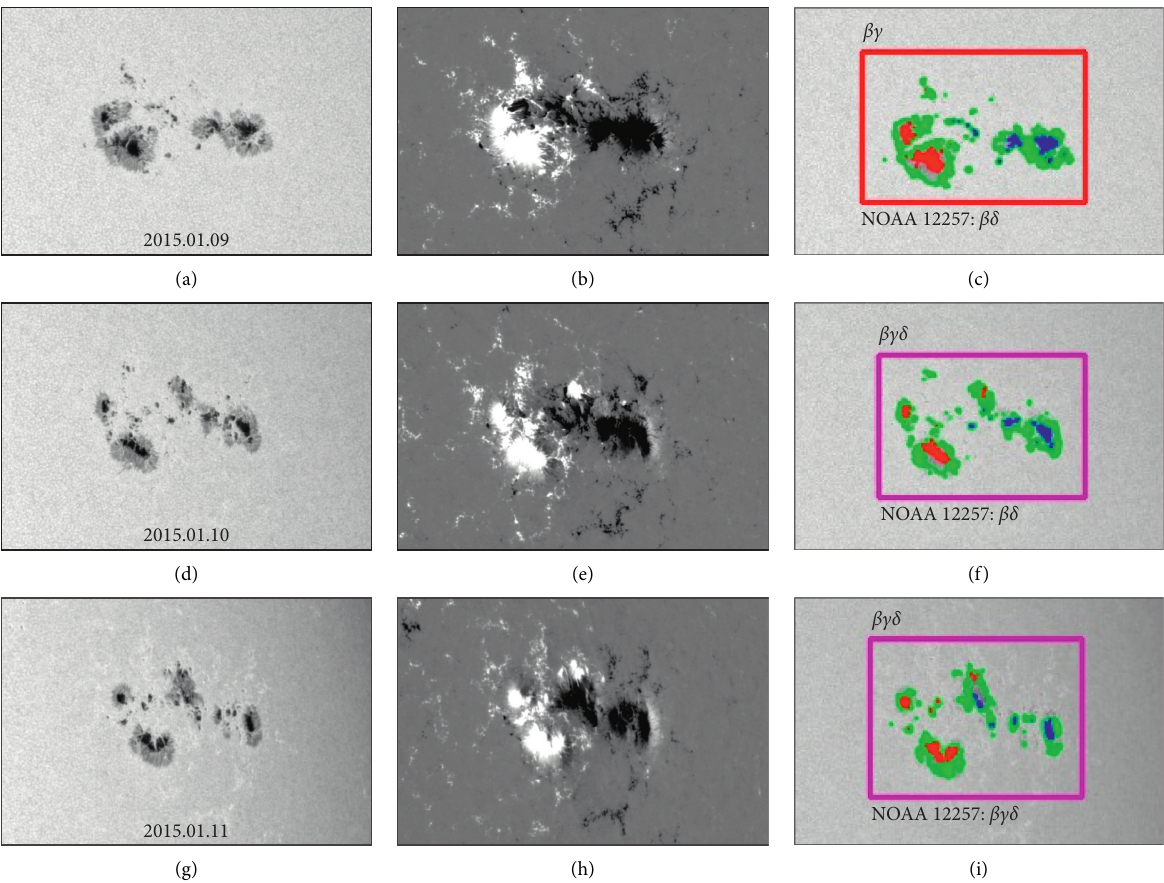
Figure 13: The classifications of NOAA 12257 given by our method and NOAA. The columns from left to right are the continuum image, magnetogram, and the detection result, respectively. The rows show the evolving procedure, which is on the 9th, 10th, and 11th of January 2015, respectively. All the times are 20:00:00 UT. The sunspot groups with solid-line boxes are detected by our method, where the classification results are displayed at the upper left of each box. The AR numbers and classification given by NOAA are manually labeled at the box